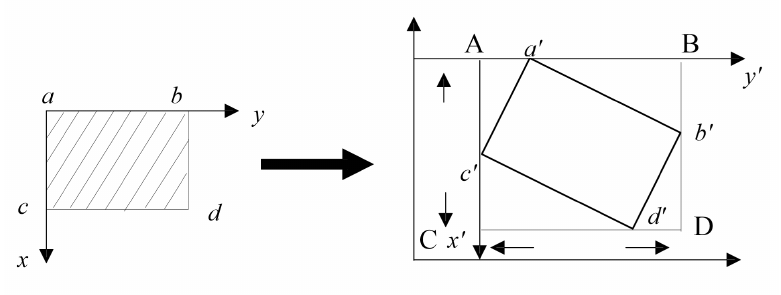
Figure 4. The overall process of detection and